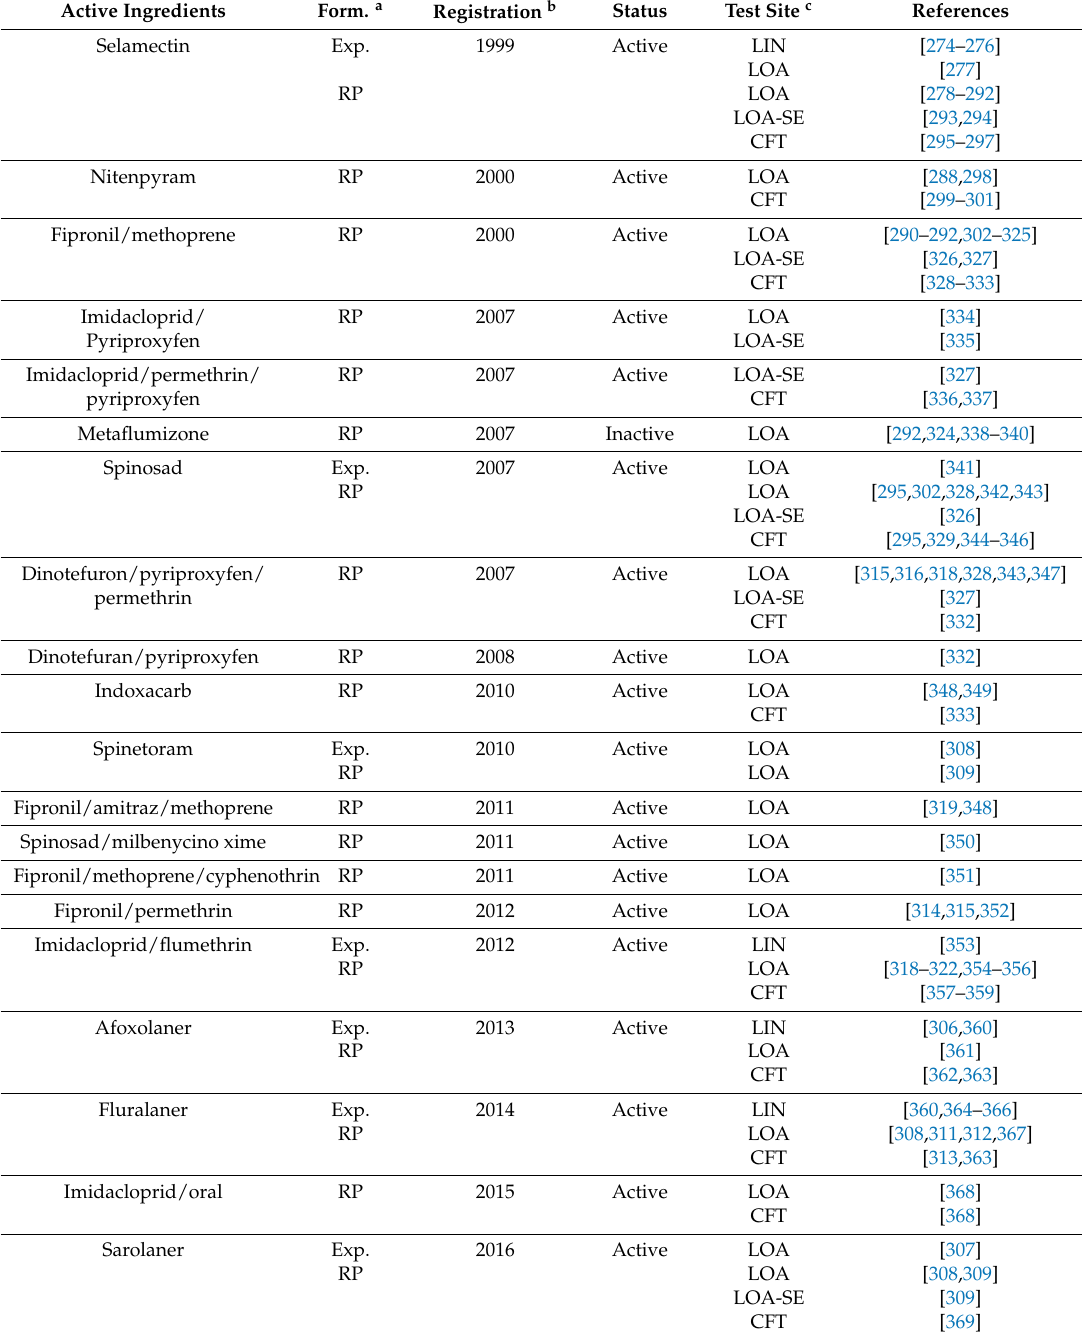
Table 2. New active ingredients and combinations tested and registered against C. felis in in vitro and in vivo